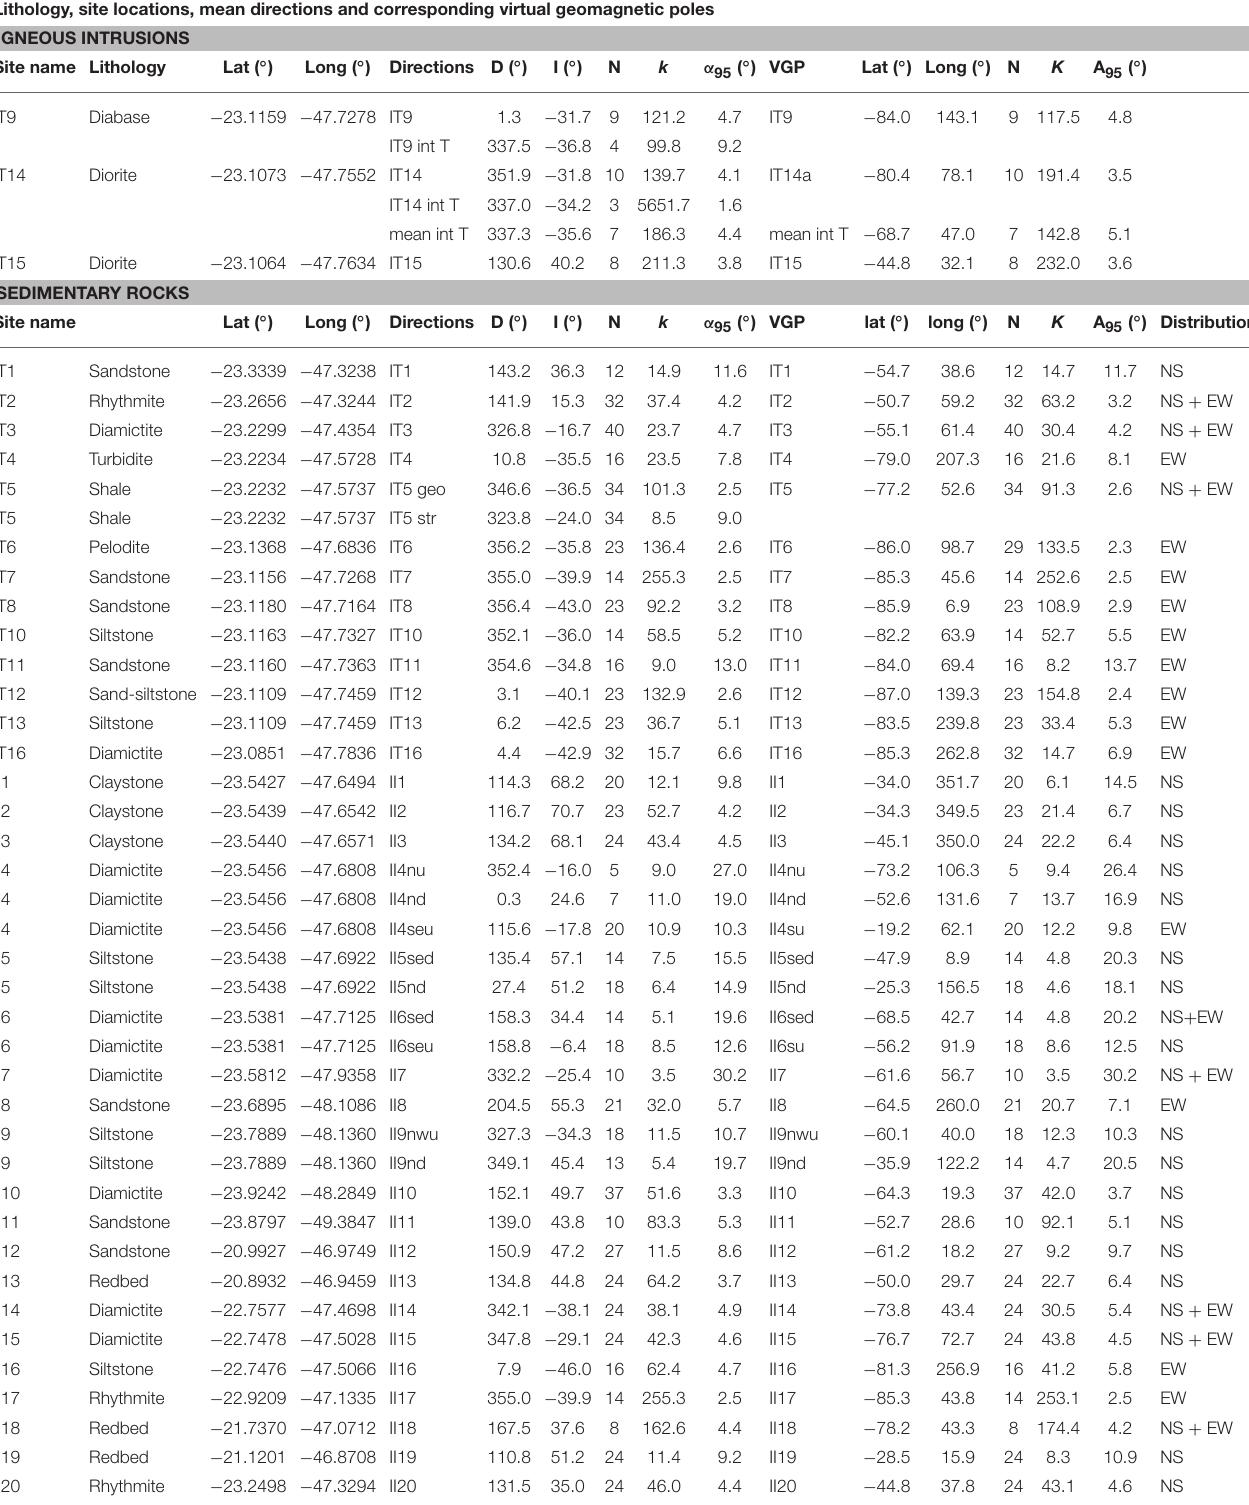
TABLE 1 | Lithology, site locations, mean paleomagnetic directions and VGPs isolated from each sampling site: N and k are number of specimens and precision parameter, respectively; a 95 and A95 are the 95% confidence circles for the directions and VGPs, respectively; for the sedimentary rocks it is also specified whether they are included in the NS, EW, or both distributions for the great circle analysis, see text for details. Lithology, site locations, mean directions and corresponding virtual geomagnetic